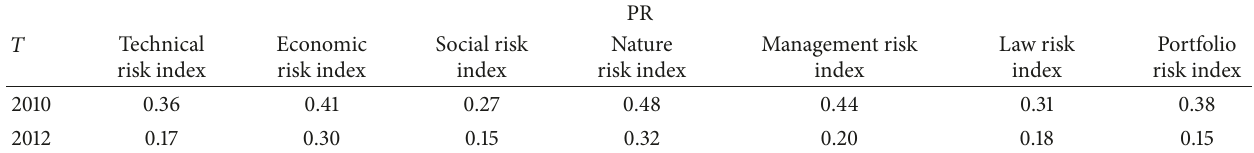
Table 12: The portfolio balanced risk comparison of the HZMB in initial and medium-term construction stage.